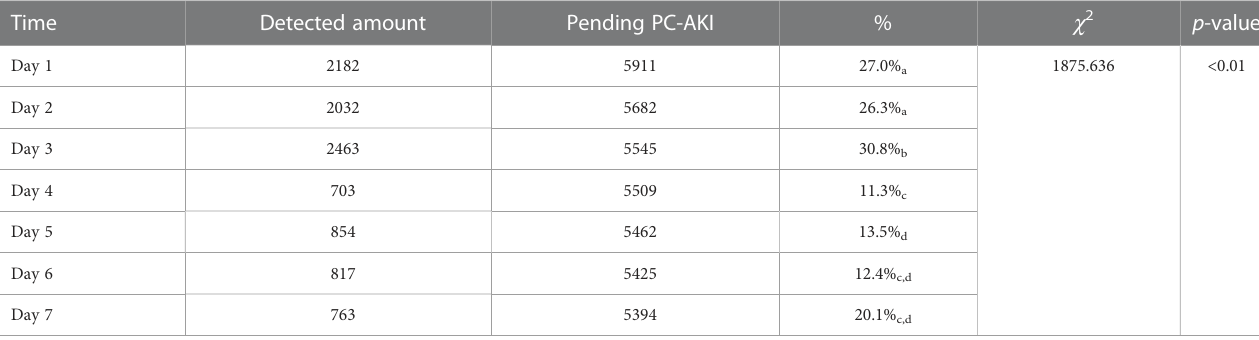
TABLE 1 Comparison of daily serum creatinine detection rate within 7 days after using contrast medium.